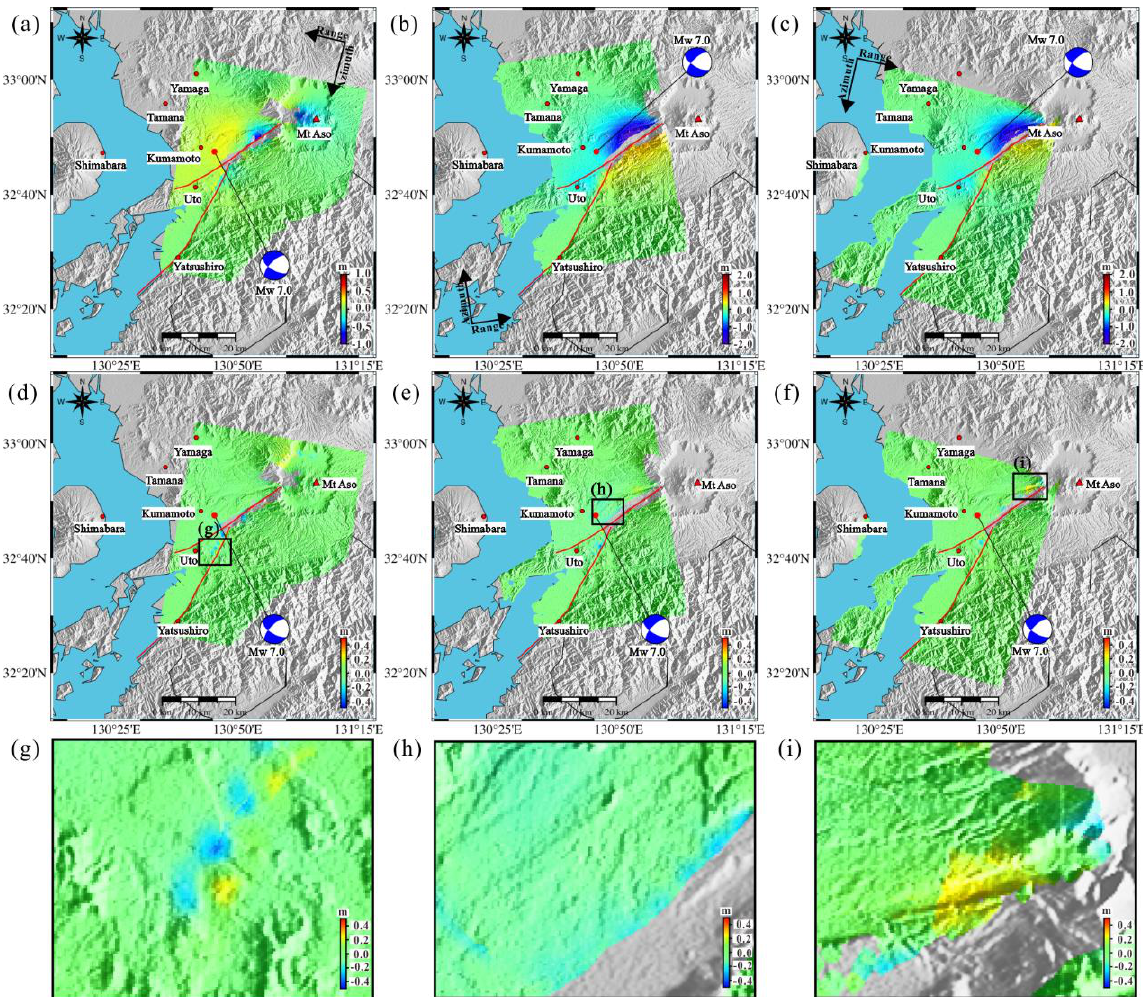
Figure 6. Similar to Figure 5 but for DR–DL solution.